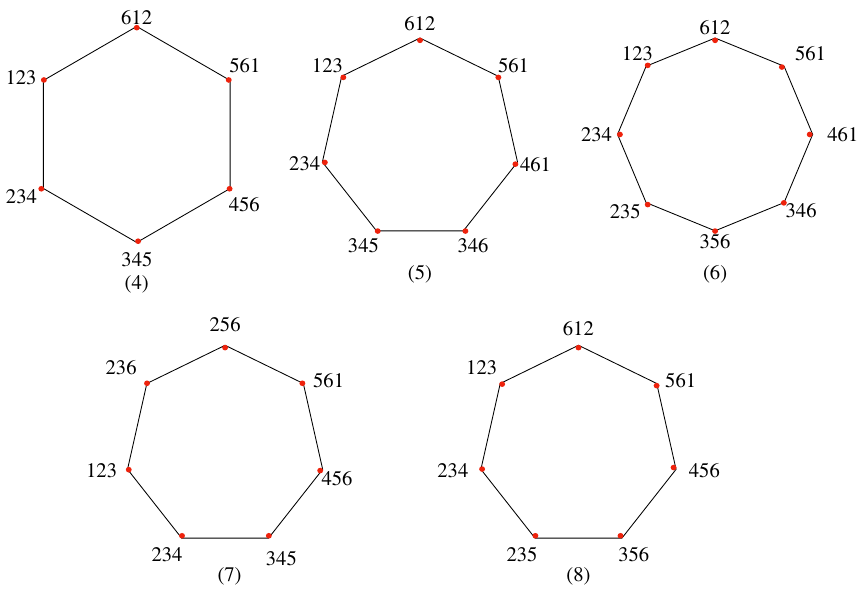
Figure 3 . Polygons for A 235